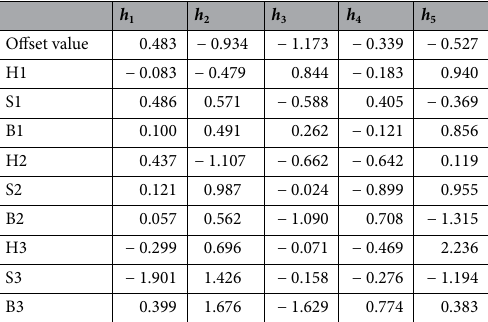
Table 3. Input layer to hidden layer connection weights and bias